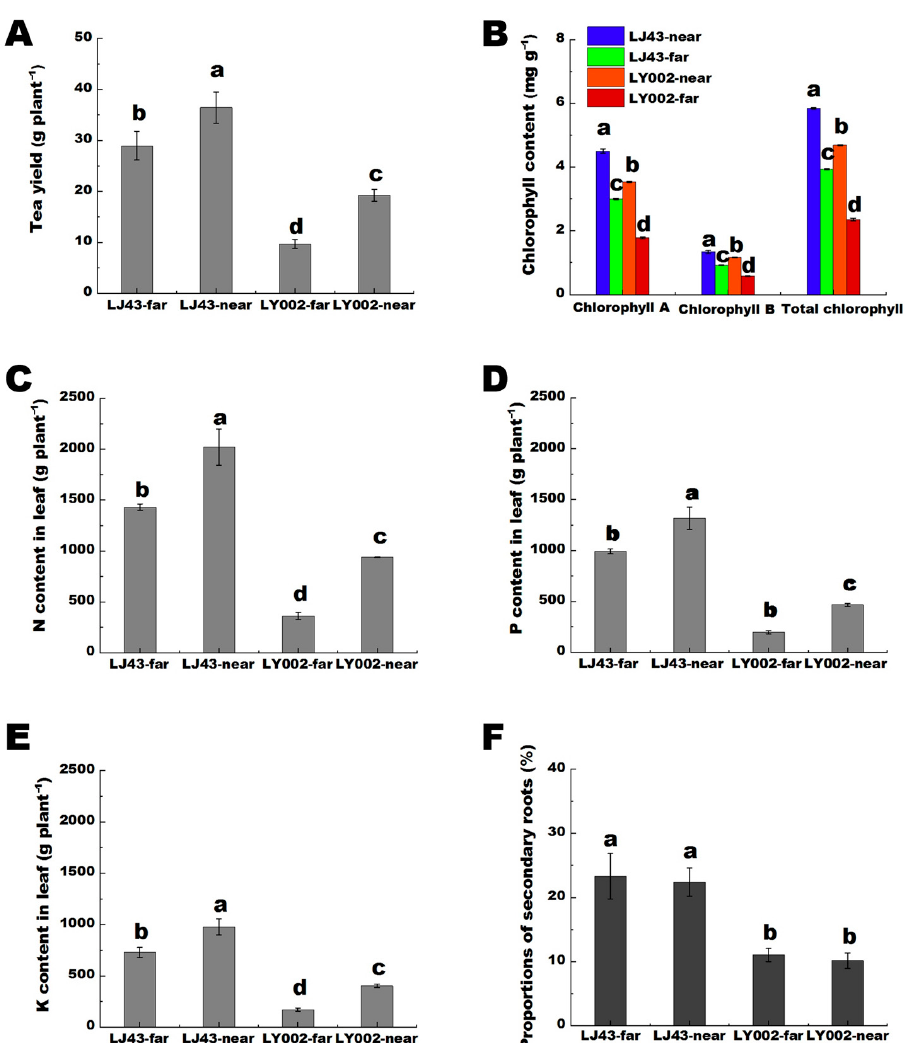
Figure 1. The differences in growth parameters of two tea genotypes under one-side fertilization mode of two rows and two plants. A : dry tea yield; B : chlorophyll content in leaves; C : N content in leaves; D : P content in leaves; E : K content in leaves; F : proportion of secondary roots. Data shows the mean ± standard deviation ( n = 3); there was a significant difference, p < 0.05, where the mean value is represented by different letters.